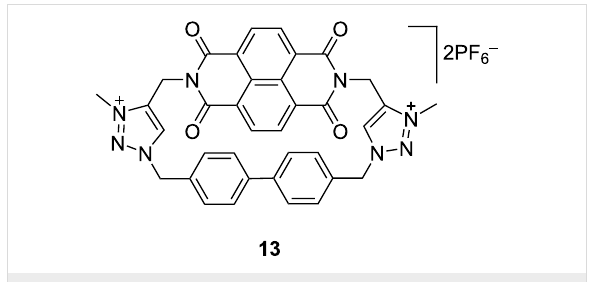
Figure 11: Chemical structure of compound 13